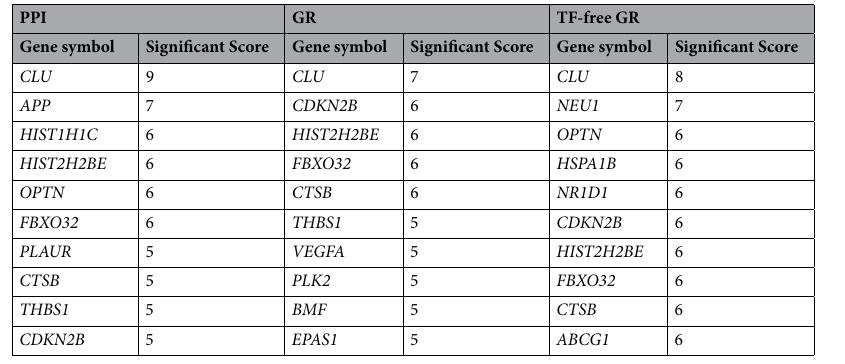
Table 1. Top 10 genes in the filtered score